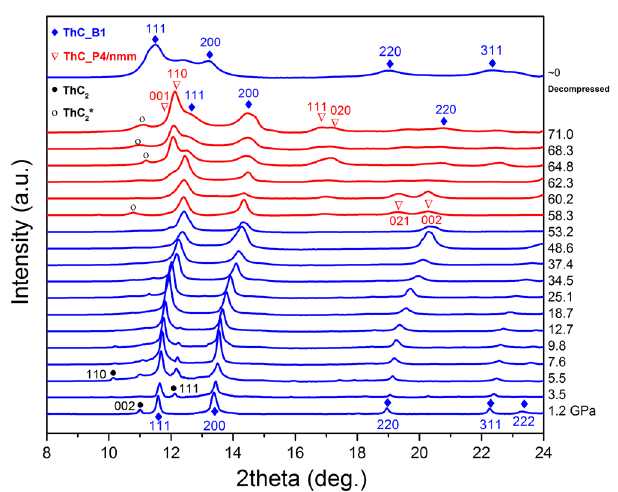
Figure 2. Integrated 1D XRD profiles of ThC powder at various pressures ranging from 1.2 GPa to 71.0 GPa. (Notes: blue diamond represents ThC-B1 phase, red triangle represents ThC-P4/nmm phase, solid black circle represents ThC 2 -C2/c phase and hollow black circle represents ThC 2 -C2/m